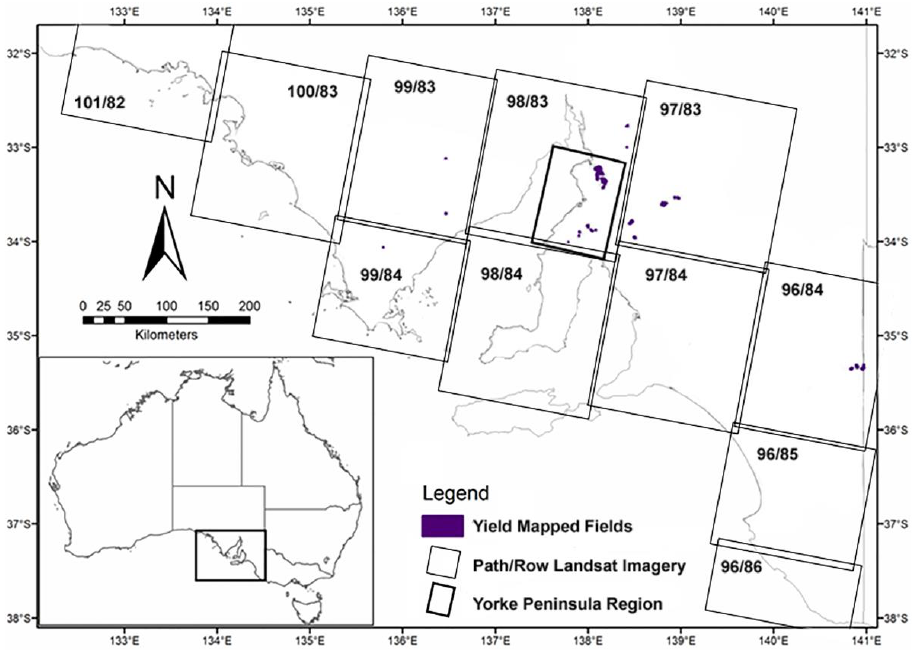
Figure 1. Location and distribution of yield-mapped fields (purple points) and the spatial distribution of Landsat images (path/row) for the Yorke Peninsula region (within Landsat image 98/83) and the state of South Australia. Inset is South Australia in relation to the Australian continent.